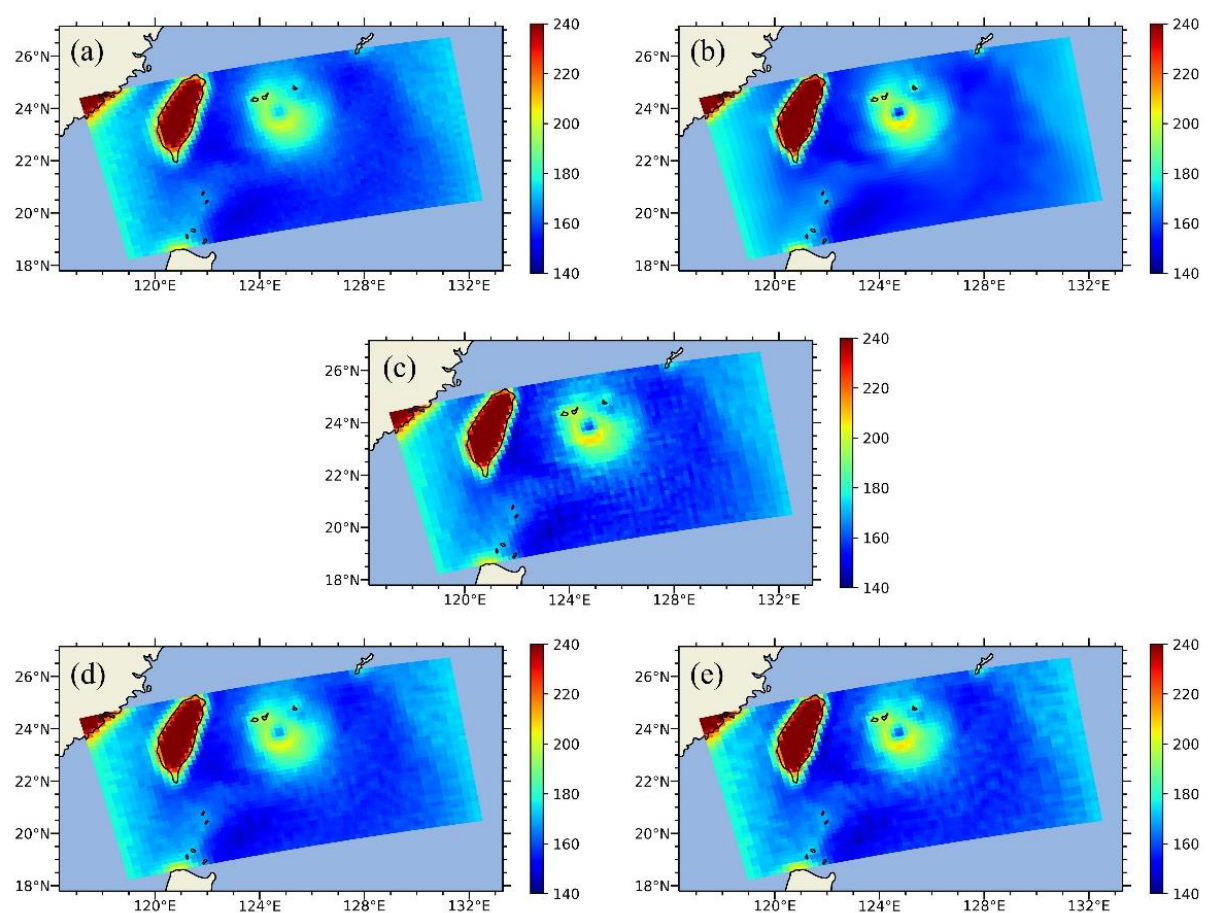
Figure 6. ( a ) Simulated brightness temperature at channel 2 with 5.2 AGF; ( b ) simulated brightness temperature with 3.3 AGF (true without noise); ( c ) brightness temperature resampled from ( a ) by BGI; ( d ) brightness temperature resampled from ( a ) by AAPP; ( e ) brightness temperature resampled from ( a ) by modified AAPP. The unit of brightness temperature is K.